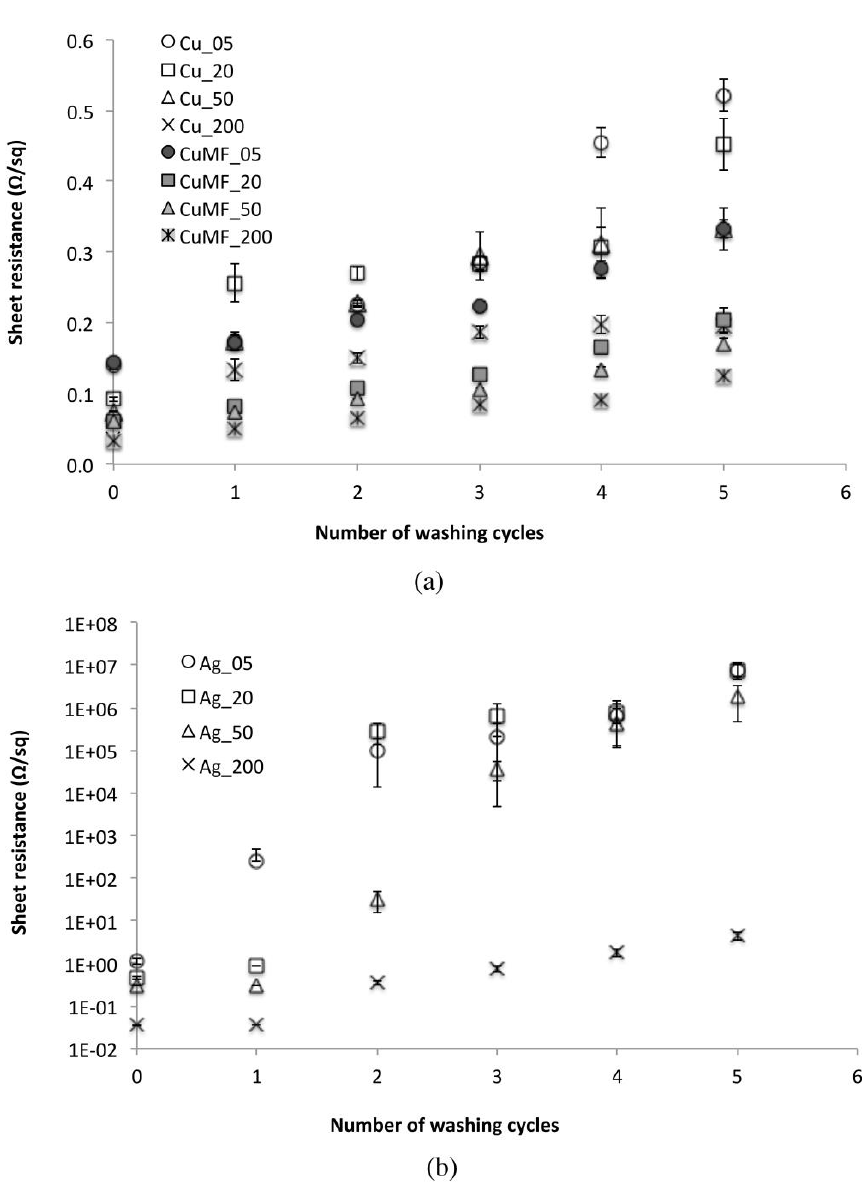
Figure 8. Sheet resistance of ( a ) the plain Cu and Cu MF formulation and ( b ) the Ag-coated samples before and after five washing cycles. Error bars represent 95% CI for the mean, and individual standard deviations were used to calculate the intervals .